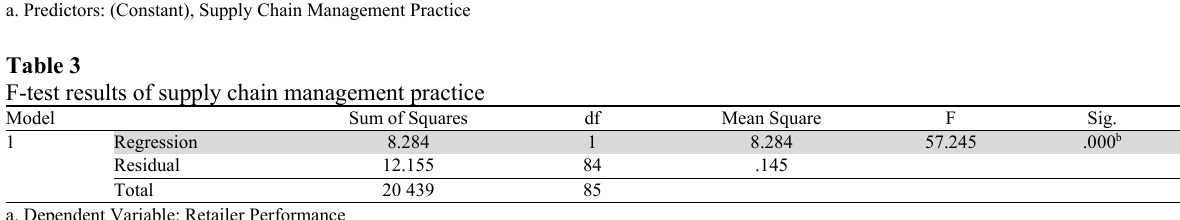
R-Square Value of Supply Chain Management Practice Model a. Predictors: (Constant), Supply Chain Management Practice